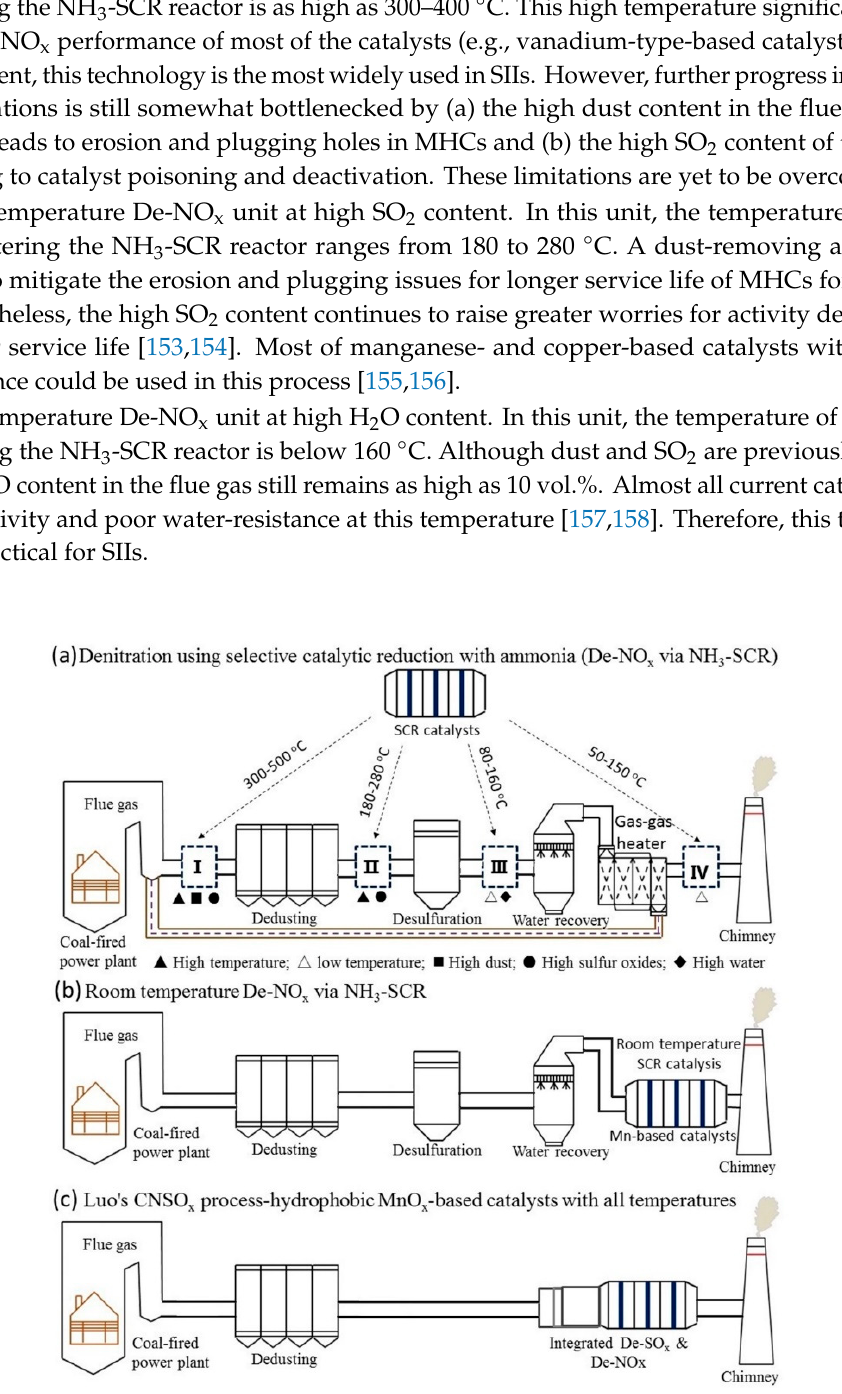
Figure 9. ( a ) Design route for De-NO x via NH 3 -SCR. (I) high-temperature at high dust content, (II) high-temperature at high SO 2 content, (III) low-temperature at high H 2 O content, and (IV) low temperature with water removal. ( b ) Room temperature De-NO x via NH 3 -SCR. ( c ) Luo’s process for treating CO, NO x , and SO x [159]. Reproduced from Ref. [159], Copyright 2018, Elsevier. Additionally, in the process of low-temperature De-NO x unit after H 2 O removal, the water vapor in the flue gas is condensed and recovered. Furthermore, the flue gas obtained after the dust removal, desulfurization, and water recovery steps can be heated to a temperature ranging from 50 to 150 °C, depending on the flue gas flow. Most Mn-based catalysts exhibit great NH 3 -SCR performance at low temperature [160]. This technique has potential in application for SIIs; however, the NO removal at low temperature still exists as a big challenge. Zhang et al. [161] found inspiring room temperature De-NO x performance in NH 3 -SCR with Mn- based MHCs. The MnO x -Fe 2 O 3 /vermiculite (VMT) catalyst showed high N 2 selectivity of 97.1% at 20 °C. The corresponding MnO x -Fe 2 O 3 /VMT MHC exhibited a NO conversion of 62.2% at NO content of 500 ppm. Additionally, MnO x -Fe 2 O 3 /VMT MHC showed excellent SO 2 resistance even at SO 2 content of 300 ppm, at which sulfate might be easily formed to foil the catalyst surface. As shown in Figure 8b, this room temperature NH 3 -SCR technology is effective for high concentration NO x removal, showing great potential for applications in SIIs. For low temperature NH 3 -SCR denitrification catalyst, it is very crucial to study denitrification mechanism for further improving its activity [162,163]. Ryu et al. [164] studied the location of active sites in NH 3 -SCR reaction, mainly at Lewis acid sites on the catalyst surface. Campisi et al. [165] functionalized HAP by ion exchange. The high dispersion of Fe 3+ species ensured the acid and redox centers. Yang et al. [166] studied the mechanism of NH 3 -SCR reaction of NO on CuMn 2 O 4 catalyst. Density functional theory calculation showed that the dehydrogenation of NH 3 was the decisive step of N 2 formation. Wu et al. [167] used hydrotalcite-like precursor to induce the modification of NiO by titanium dioxide (Figure 10a), which produced a good interface effect in the calcination process